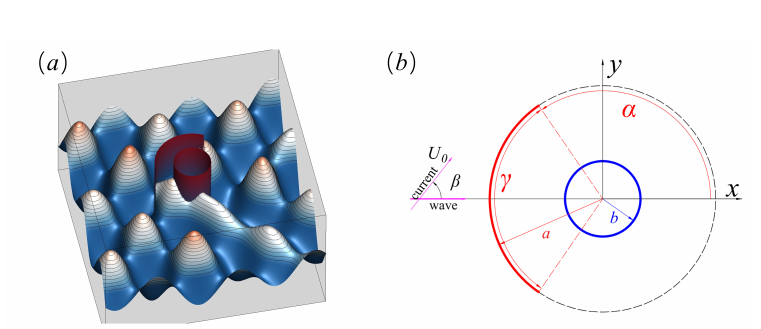
Figure 1. Definition sketch: ( a ) bird’s-eye view; ( b ) top